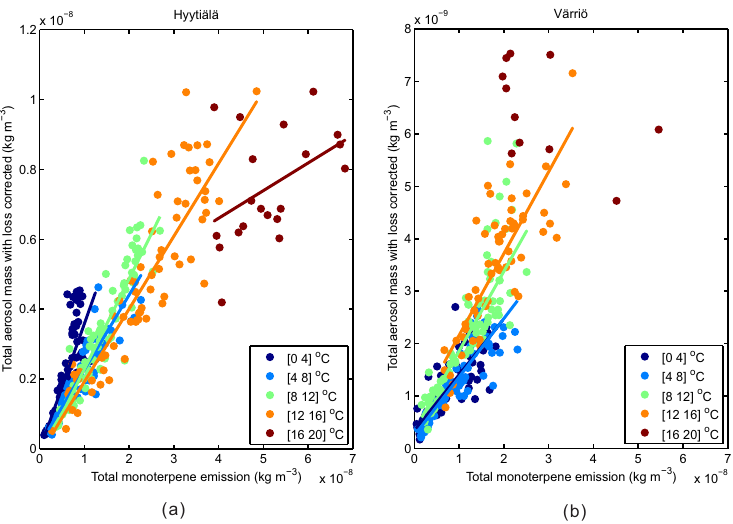
Figure 8. Total aerosol masses with deposition loss corrected vs. total monoterpene emissions among the five temperature bins (a) at the SMEAR II station, and (b) at the SMEAR I station. The marker colours of legends represent the binned temperatures. Solid lines depict fitting slopes between these two quantities at each temperature bin.